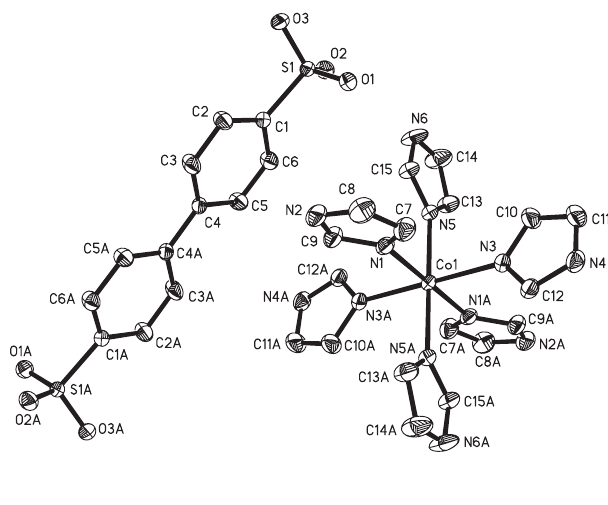
Table 1. Data collection and handling.